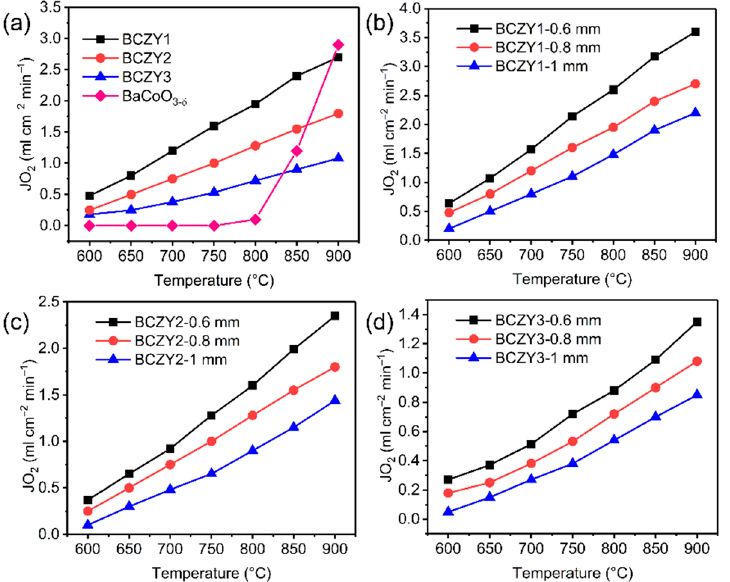
Figure 3. ( a ) Oxygen permeation rates of BaCoO 3 −δ , BCZY1, BCZY2 and BCZY3 membranes with Ar as the sweeping gas at 600–900 °C; Oxygen permeation rates of ( b ) BCZY1, ( c ) BCZY2 and ( d ) BCZY3 membranes with different